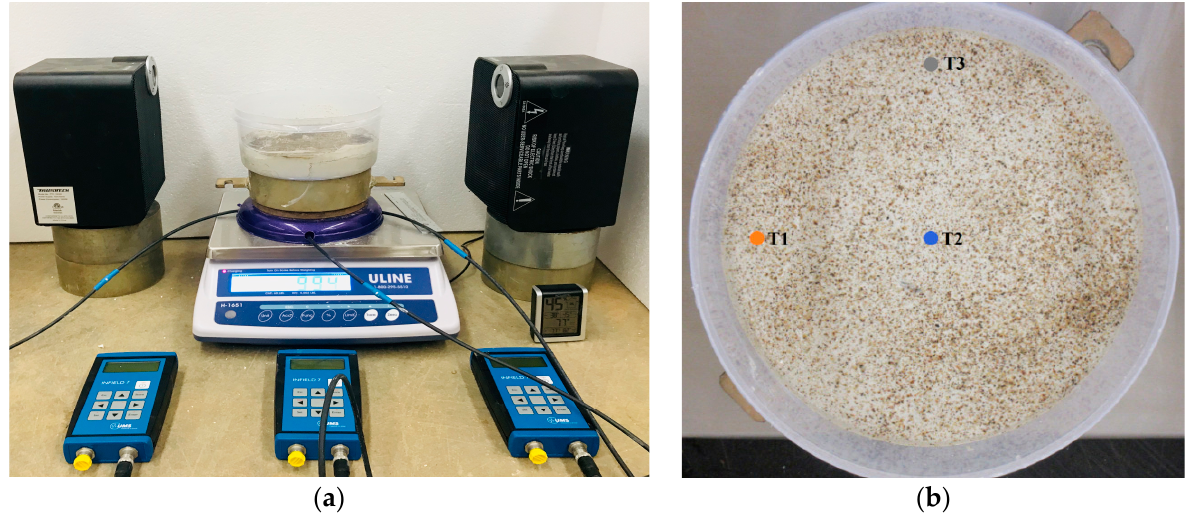
Figure 2. Photos of ( a ) the experimental setup for the desiccation test, and ( b ) tensiometer locations (T1, T2, and T3). (T1, T2, and